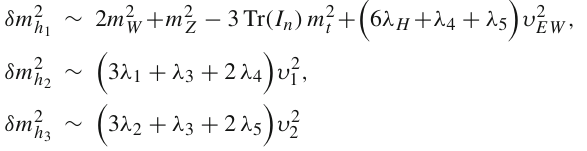
Fig. 2 Correction δ m 2 (λ ,λ ) plan.Weset m 4 5 ≤ 1 . 2 TeV, and 10 GeV ≤ v m h 3